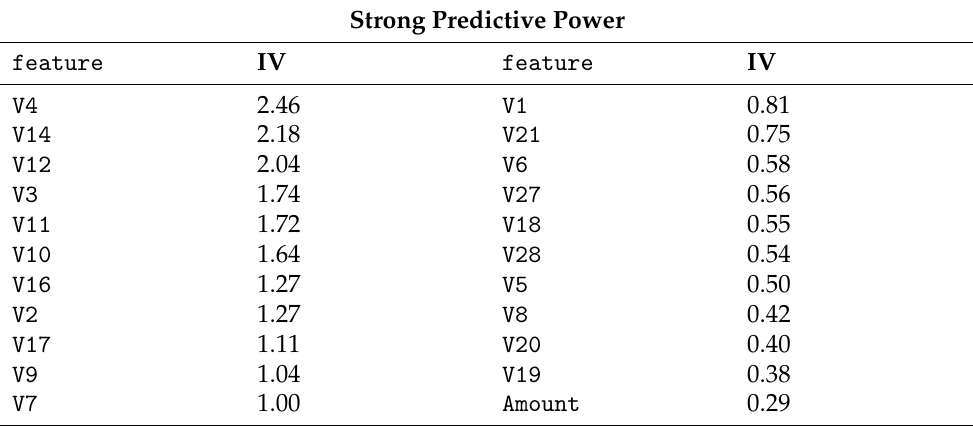
Table 8. Extended CreditCard dataset information value—Part 1.